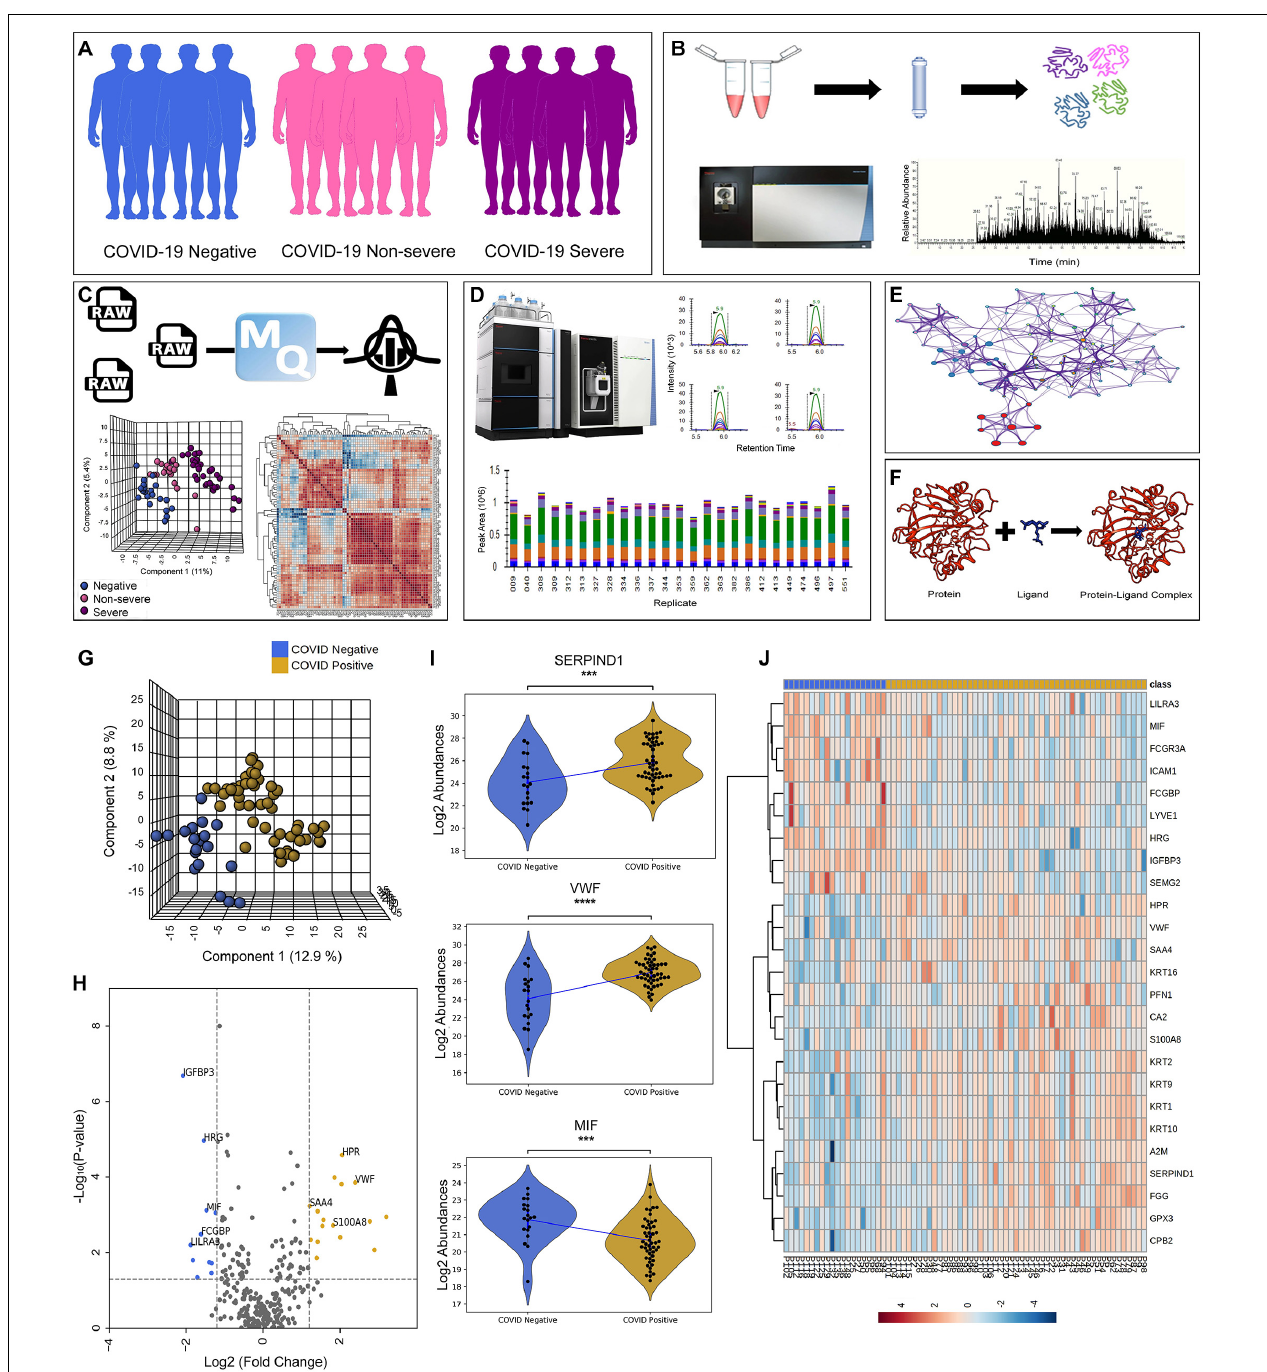
FIGURE 1 | Schematics of plasma proteomics and proteins dysregulated in the COVID-19 positive when compared with negative. (A) Sample cohort size consisting of 20 COVID-19 negative, 18 COVID-19 non-severe, and 33 COVID-19 severe patients. (B) Schematic workflow of label-free quantification under discovery proteomics. (C) Overview of statistical data analysis. (D) Workflow of validation using multiple reaction monitoring (MRM) approach showing the representative peaks of synthetic peptides. (E,F) Outline of biological network analysis using Metascape and docking study performed using AutoDock Vina, respectively. (G) Partial least squares–discriminant analysis (PLS-DA) of 71 patient samples showing the segregation between COVID-19 positive (including severe and non-severe) and COVID-19 negative samples. (H) Volcano plot showing significant differentially expressed protein between COVID-19 positive and negative. (I) Violin plot of few of the dysregulated host proteins such as SERPIND1, VWF, and MIF protein in COVID-19 positive (***1.00e-04 < p ≤ 1.00e-03). (J) Heatmap of top 27 significant differentially expressed proteins in COVID-19 positive and negative.